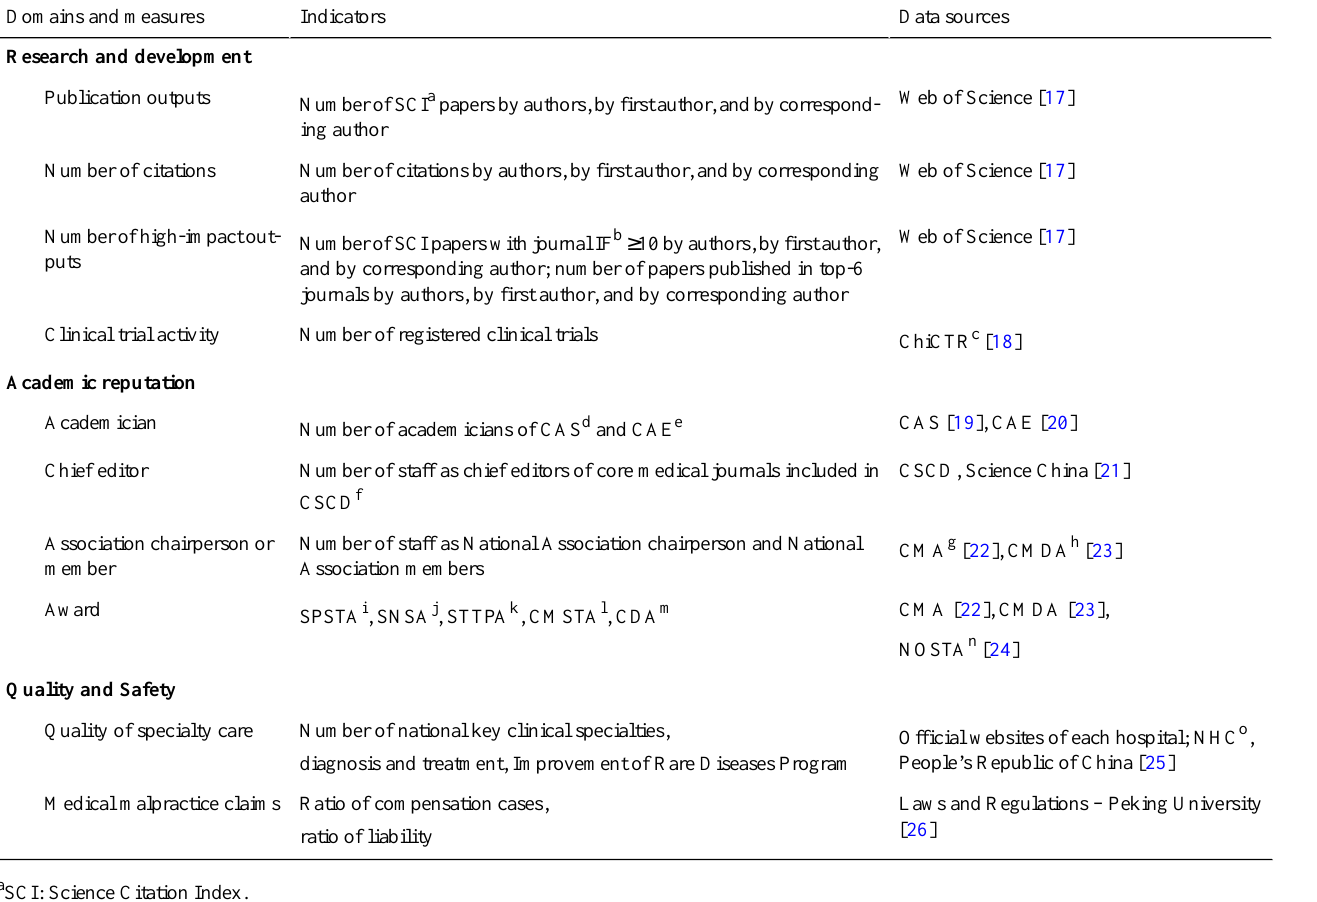
Table 2. Summary of measures and clustering of performance indicators into three domains: research and development, academic reputation, and quality and